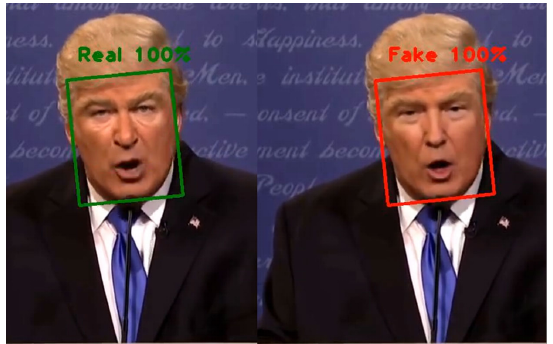
Figure 1. Frames from Deep-Fake video of former US